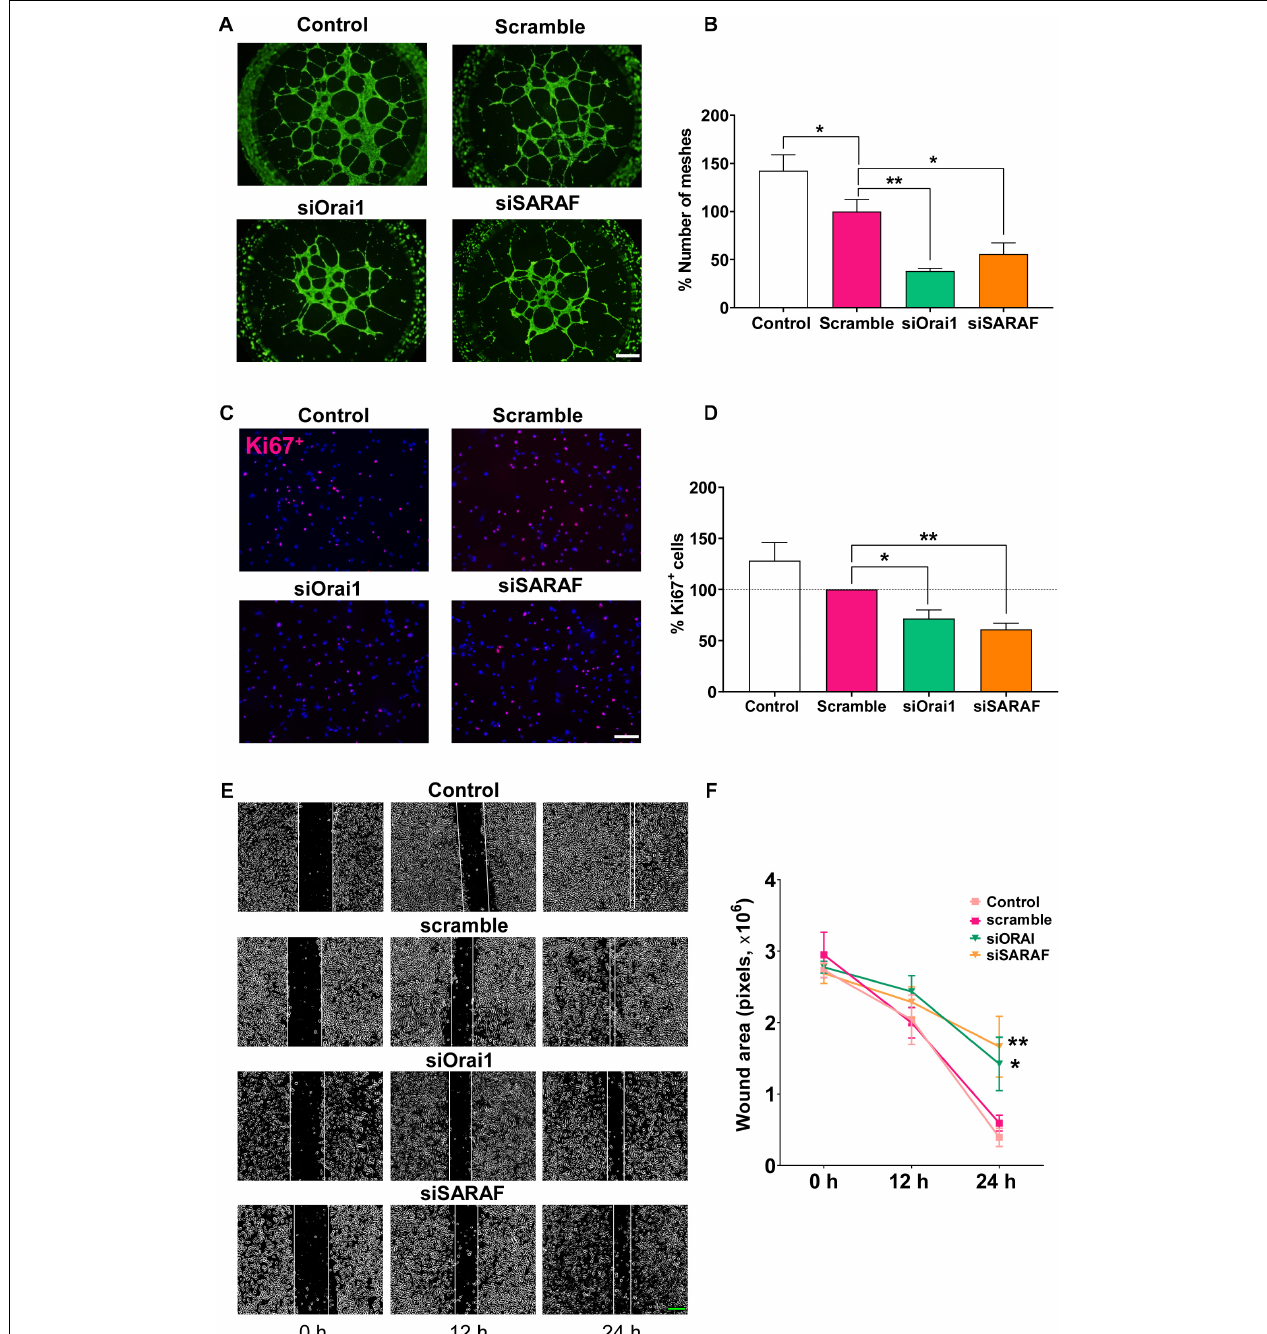
FIGURE 5 | siRNA-mediated inhibition of Orai1 and SARAF attenuates HUVEC tube formation, proliferation, and migration. (A) Fluorescence images ( × 4 objective; scale bar = 500 µ m) and (B) summary data (% of meshes number normalized to scramble) obtained from HUVECs embedded on Matrigel and stained with Calcein-AM of control (white) and transfected with scramble (pink), siRNA Orai1 (green), and siRNA SARAF (orange) ( n = 5 to 6). (C) Merged representative images ( × 20 objective; scale bar = 100 µ m) of HUVECs stained with Ki67 + (red) and DAPI (blue) in control and in cells transfected with scramble, or siRNA Orai1 and SARAF ( n = 5). (D) Bar graph shows the percentage of Ki67 + control (white bar) and transfected HUVECs with siOrai1 and siSARAF, normalized to scramble. (E) Phase-contrast imaging ( × 10 objective; scale bar = 200 µ m) of the HUVEC wound healing assay modified with ImageJ. Images were taken at 0, 12, and 24 h after the scratch from control HUVECs and form cells transfected with scramble siRNA, and siRNA against Orai1 and SARAF. (F) Graph shows summary data of the evolution of the wound area in experiments as in (E) ( n = 4). Values are presented as the means ± S.E.M. Significance is indicated by (*) and (**) for p < 0.05 and p < 0.01,